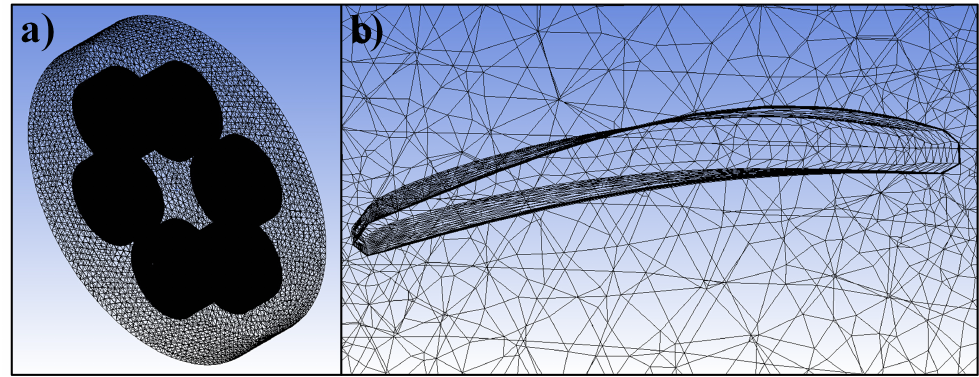
Figure 2. The prepared mesh: ( a ) entire domain; ( b ) close-up on the boundary layer of the rotor.